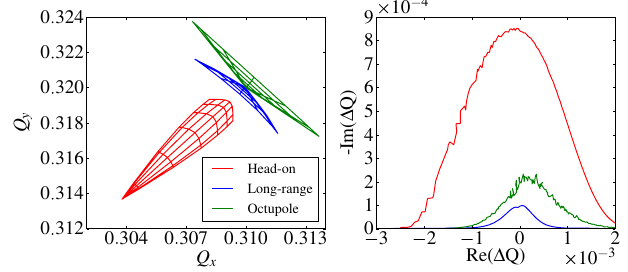
FIG. 13. Comparison of footprints and corresponding stability diagrams generated by octupoles powered with þ 500 A, long range in IP1 and 5 or head-on in IP1 and 5. The machine and beam parameters are those of the nominal